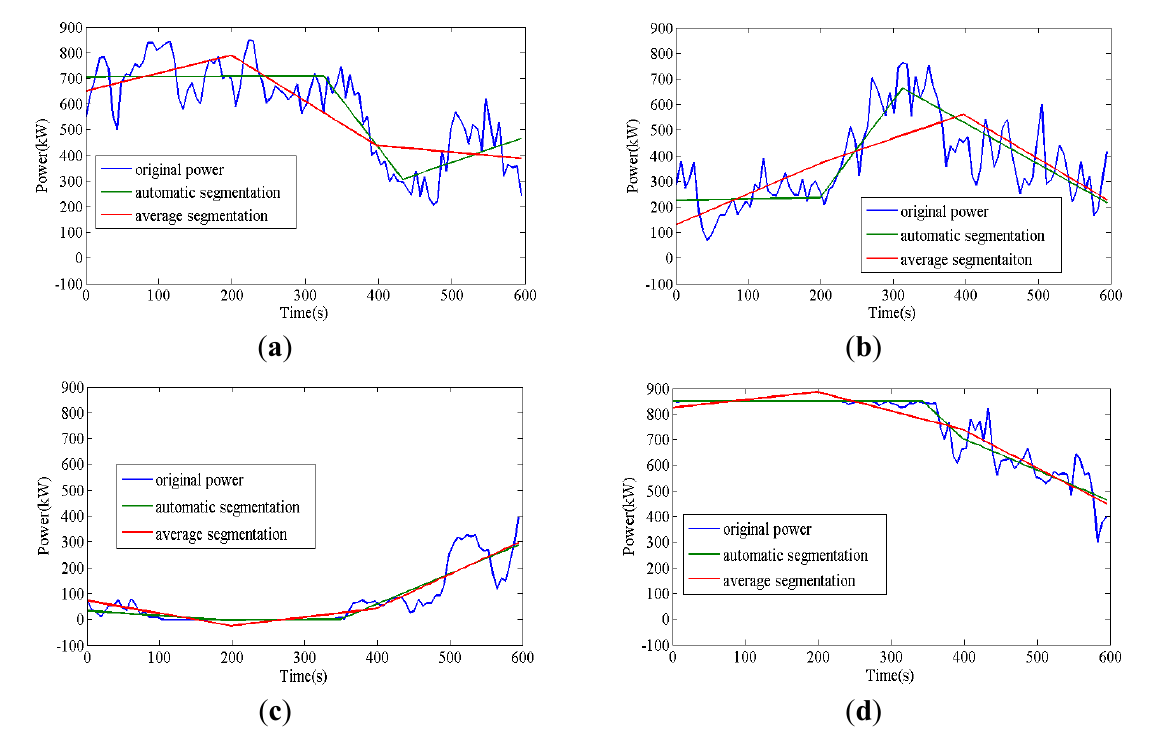
Figure 5. Regulation effect with average segmentation and automatic segmentation